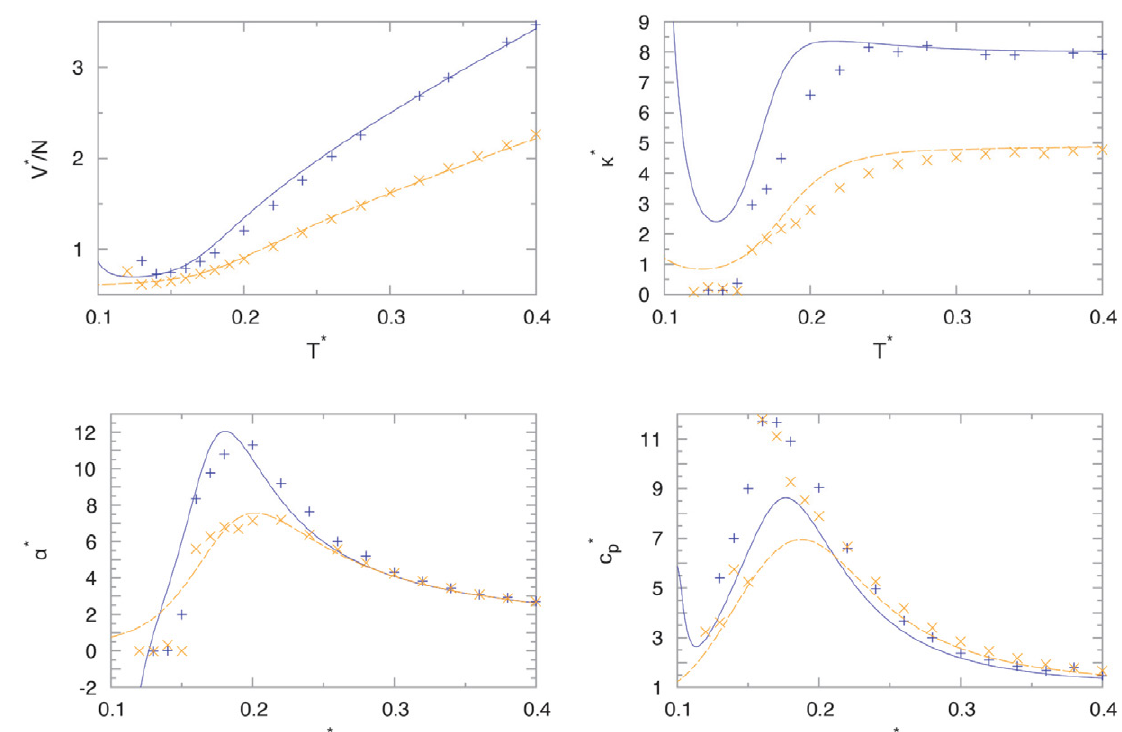
Figure 11: Temperature dependence of the molar volume (V * /N), heat capacity (c p *), thermal expansion coefficient (α*), and isothermal compress- ibility (κ*), for 3D MB water for pressures p* = 0.19 (orange) and p* = 0.12 (blue). Results from the theory are plotted with lines and from the com- puter simulations by symbols.